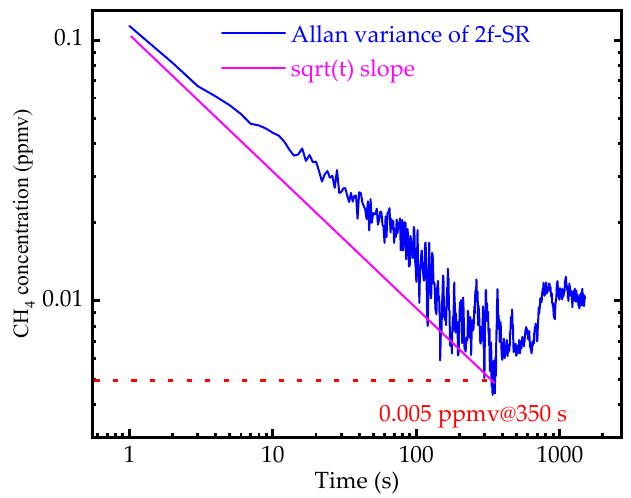
Figure 7. Allan variance of 2f-SR data of a 100 ppmv CH 4 standard gas.